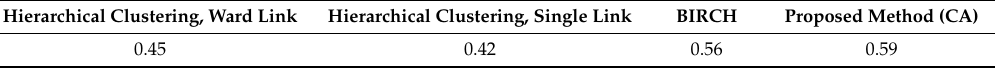
Table 3. Results of the Dunn index for evaluation of clustering